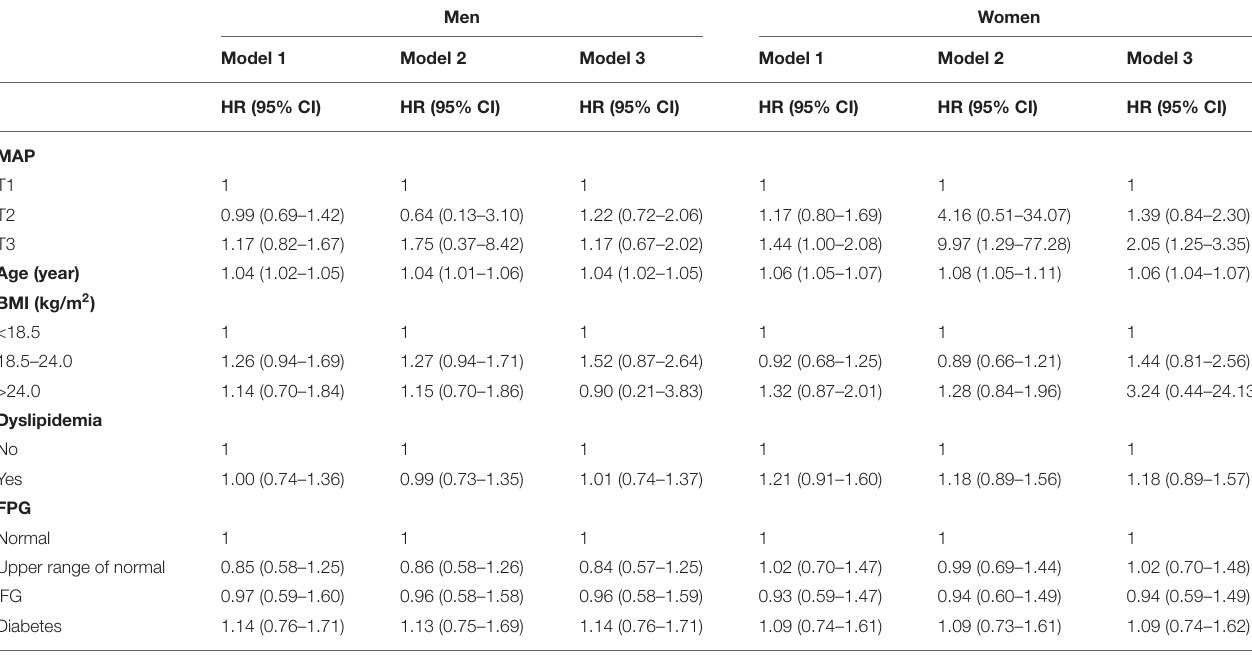
TABLE 6 | Analysis of variables that may affect the association between mean arterial pressure (MAP) tertiles and risk of carotid